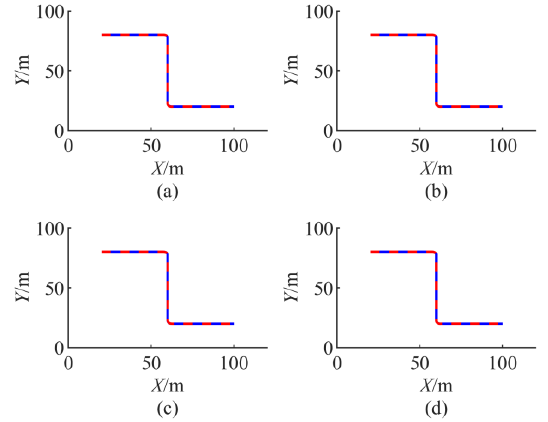
Figure 1. The trajectory when velocity is 2 m/s. The red line is the trajectory. The blue line is the reference path. ( a ) linear model predictive control (LMPC). ( b ) linear error model predictive control (LEMPC). ( c ) nonlinear model predictive control (NMPC). ( d ) nonlinear error model predictive control (NEMPC).